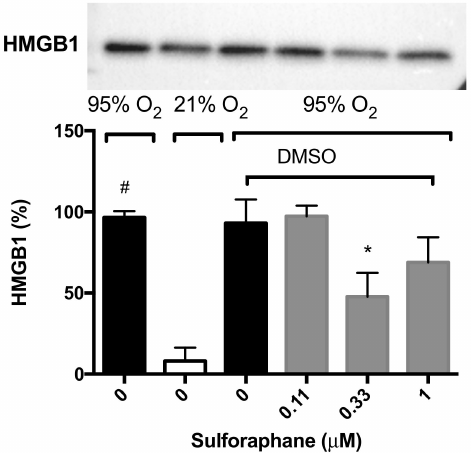
Figure 4. Sulforaphane (SFN) decreases the hyperoxia-induced extracellular accumulation of HMGB1 in RAW 264.7 cells. RAW 264.7 cells were exposed to 21% O 2 (white bar) or 95% O 2 (black bar) for 24 h in the presence of various concentrations of SFN (grey bars) (diluted in DMSO as the vehicle). HMGB1 levels in the cell culture supernatant were determined using Western blot analysis. The blot indicates the bands of HMGB1 in each group. Each value represents the mean ± SEM of at least three independent experiments. * p ≤ 0.05 compared to 0 µ M SFN vehicle control group. # p ≤ 0.05 compared to 21% O 2